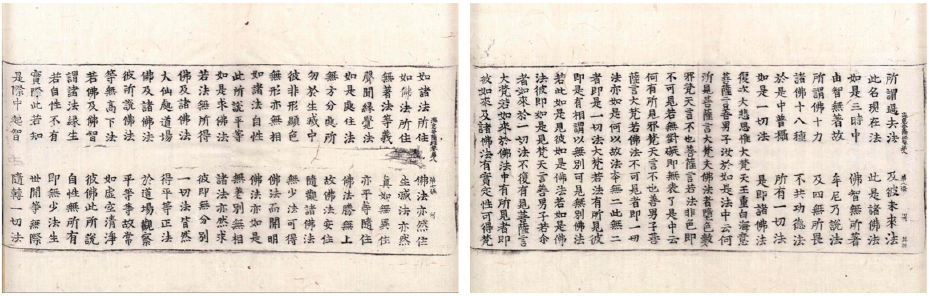
Figure A2. The Sgm inscriptions from Kedah Site 2. Plate 8 in (Wales 1940). 3. Woodblock edition in the Tripi ṭ aka Koreana (the 2nd Kory ŏ edition, 13th century CE).